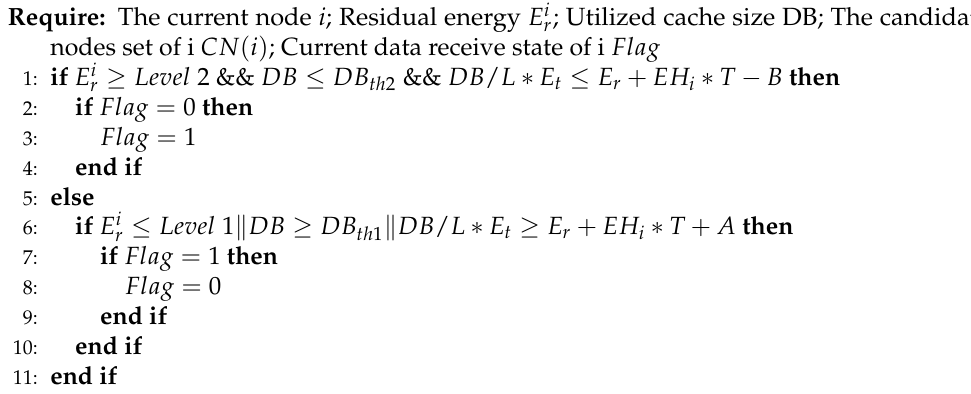
Algorithm 1 Reception State Adjustment